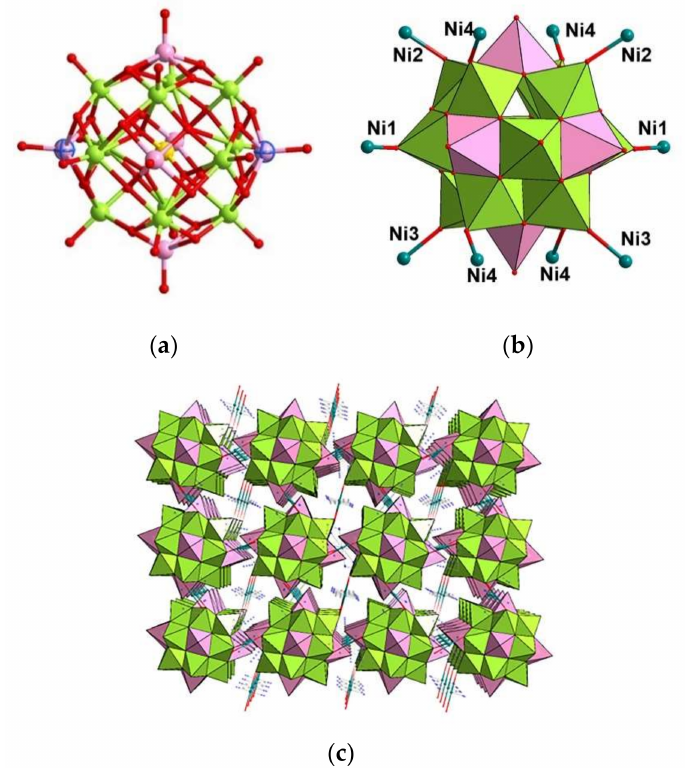
Figure 1. Crystal structure of 1 . ( a ) Ball-and-stick representation of {PNb 12 O 40 (VO) 5 } in 1 . ( b ) Con- nections between {PNb 12 O 40 (VO) 5 } and nickel ions. ( c ) The 3D framework of 1 viewed along the b direction. Color codes: Nb, green; V, pink; Ni, dark green; P, yellow; O, red; N, blue; C,